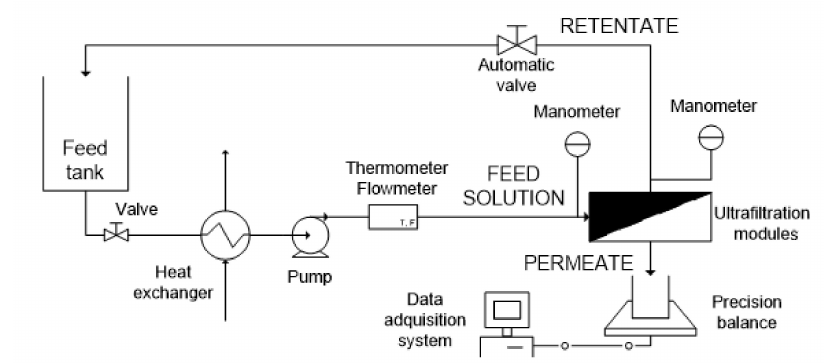
Figure 2. Schematic diagram of the ultrafiltration laboratory